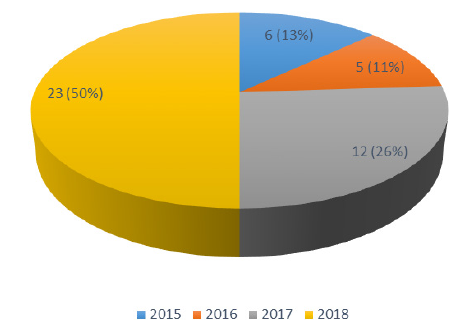
Figure 1. Incidence of PAI per year.